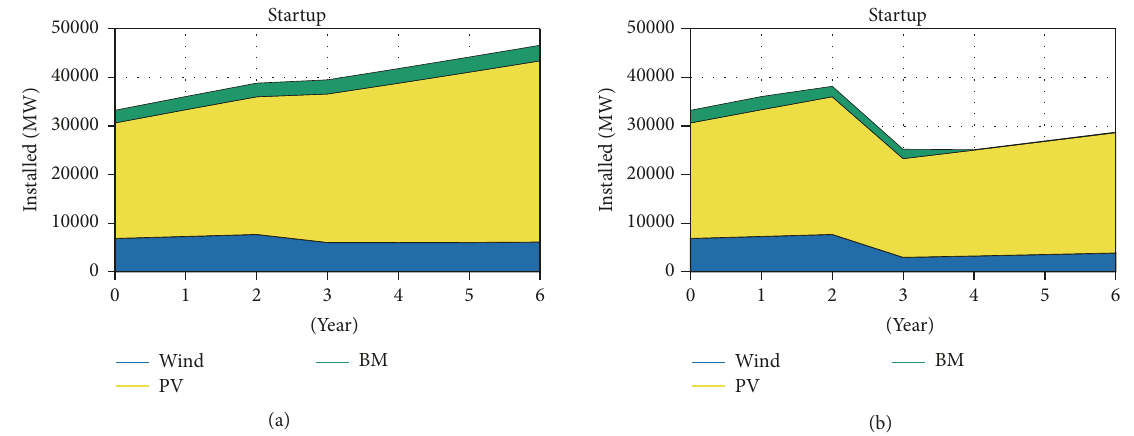
Figure 7: Evolution of the marketers’ portfolios for Scenario 1 (a) and Scenario 2